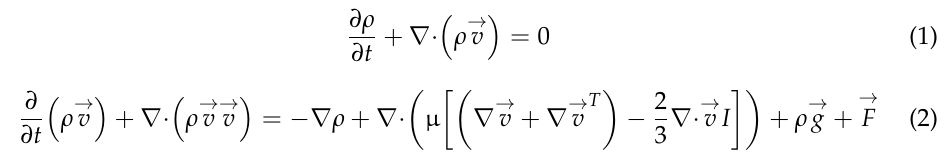
Figure 3. Mesh independence test results for ( a ) 50-year-old model, ( b ) 60-year-old model, ( c ) 70-year-old model, and ( d ) deposition fraction comparison with available experimental data [51,52,53,54].